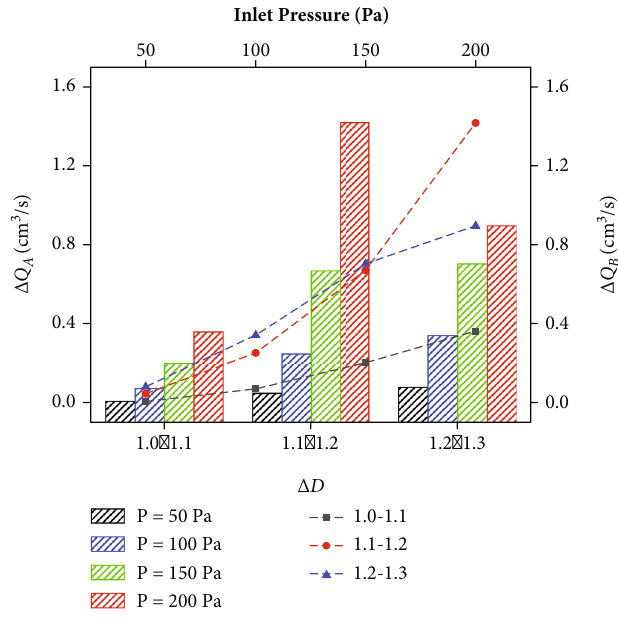
Figure 6: The relationship between fl ow rate loss and fractal